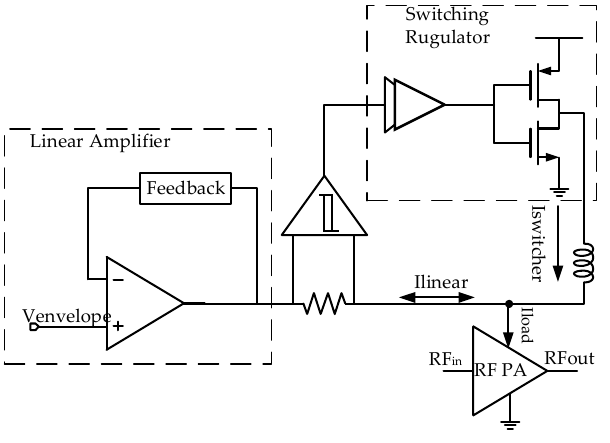
Figure 1. The system block diagram of the hybrid ET modulator.